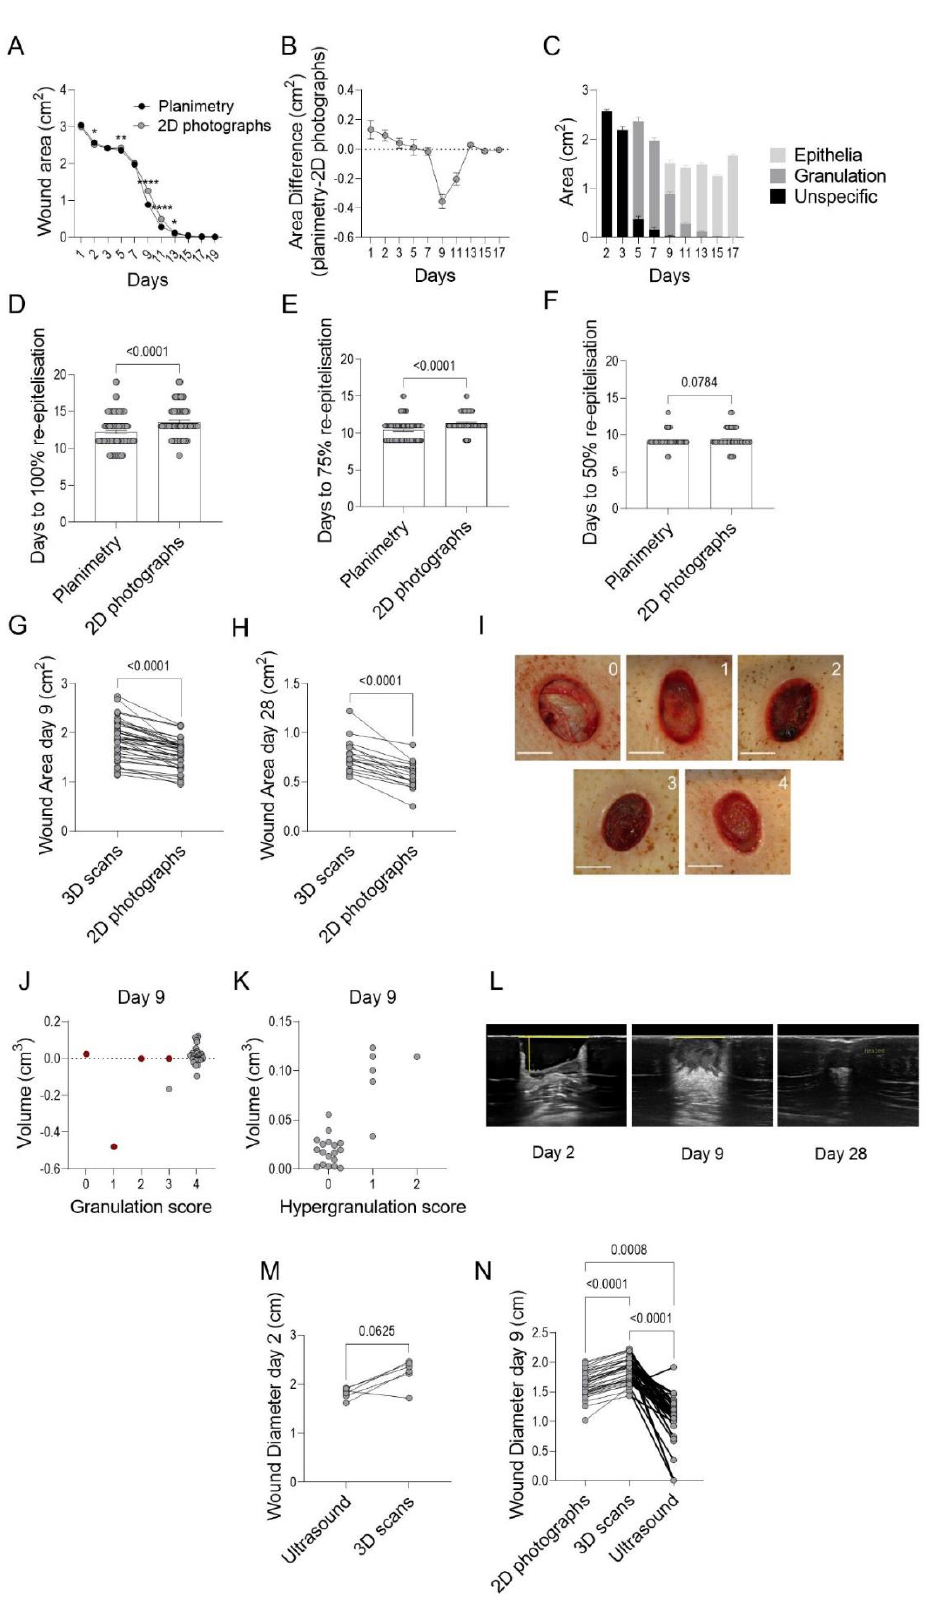
Figure 2. Comparisons of different wound assessment methods. Wound areas from Cohort A were measured by on-site planimetry ( A ) and from 2D photographs ( B ), n = 18, N = 93–96), and the